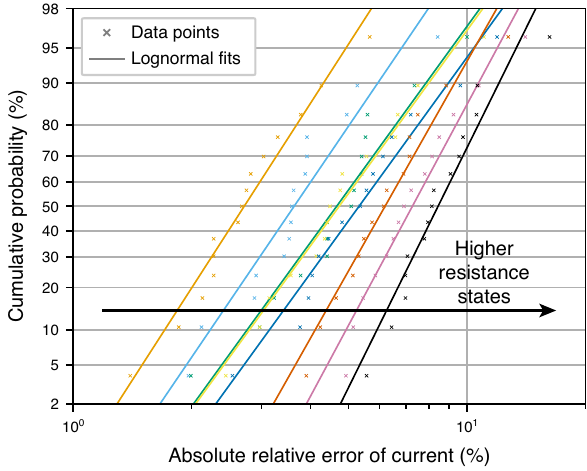
Fig. 7 Random telegraph noise in an aVMCO device. Cumulative probability plots of RTN-induced relative current deviations for all eight resistance states of aVMCO RRAM device. Lognormal fi ts are shown for each resistance